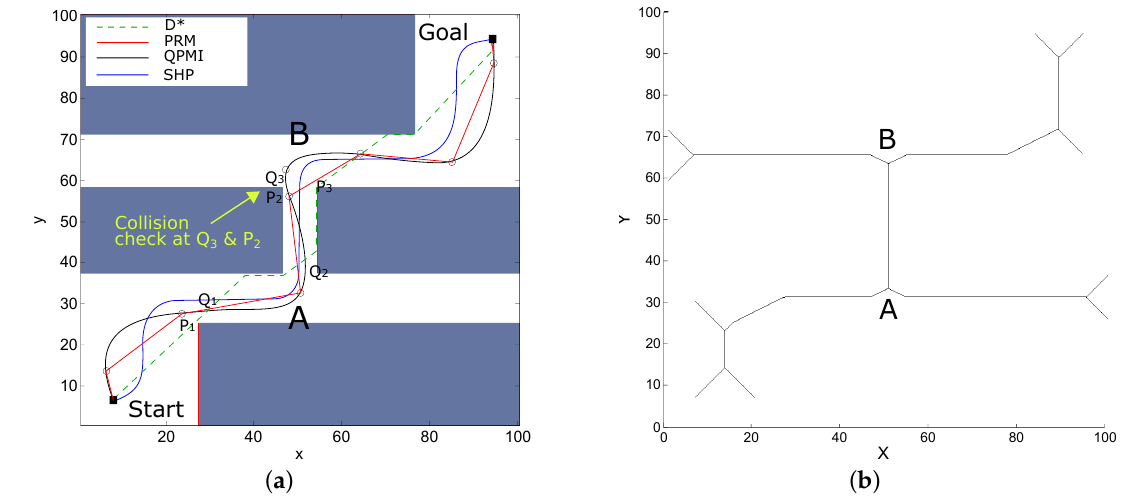
Figure 11. Safety and user experience while smoothing paths. ( a ) Paths generated by D* [19], PRM [25], QPMI [39], and SHP [117] in dotted green, red, black, and blue colors, respectively. ( b ) The skeleton path of the environment of Figure